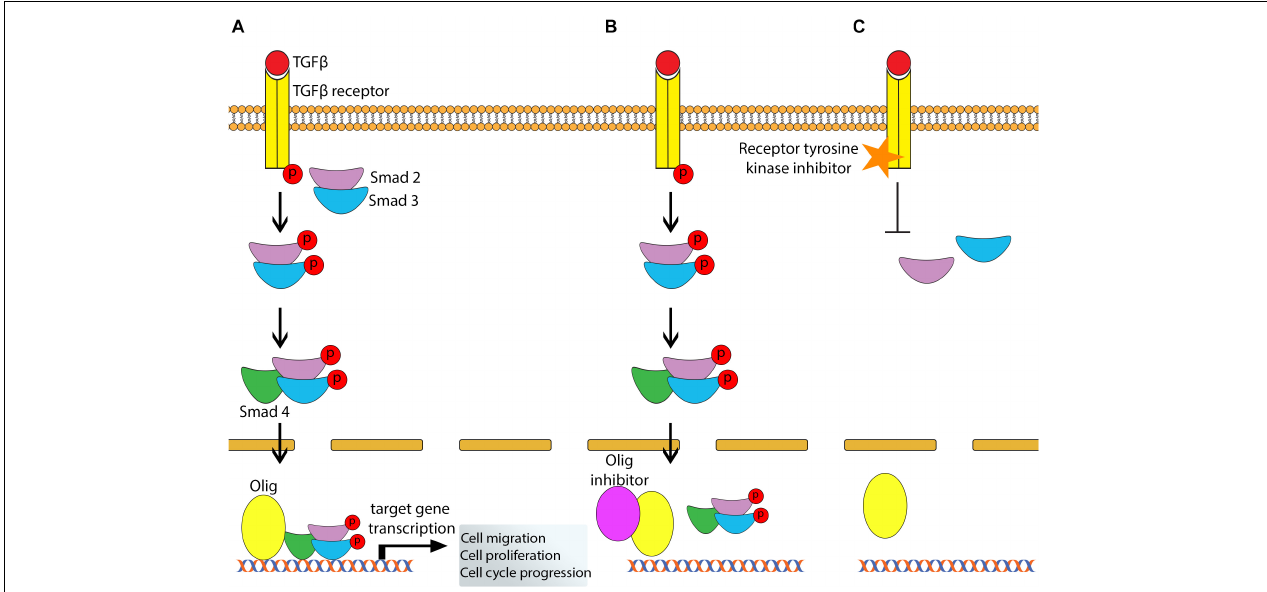
FIGURE 3 | Proposed Olig-directed drug targets. (A) Summary of TGF β signaling. Binding of TGF β to its TGF β receptor leads to recruitment and subsequent phosphorylation of Smad2/3 complex. Phosphorylated Smad2/3 recruits Smad4 which translocate to the nucleus and binds with Olig protein to allow gene transcription for specific biological processes (e.g., cellular migration). (B) An Olig inhibitor is bound to the Olig protein to prevent its binding to E-box motifs, thus blocking gene transcription. (C) A receptor tyrosine kinase inhibitor blocks phosphorylation of the TGF β receptor preventing TGF β signaling.